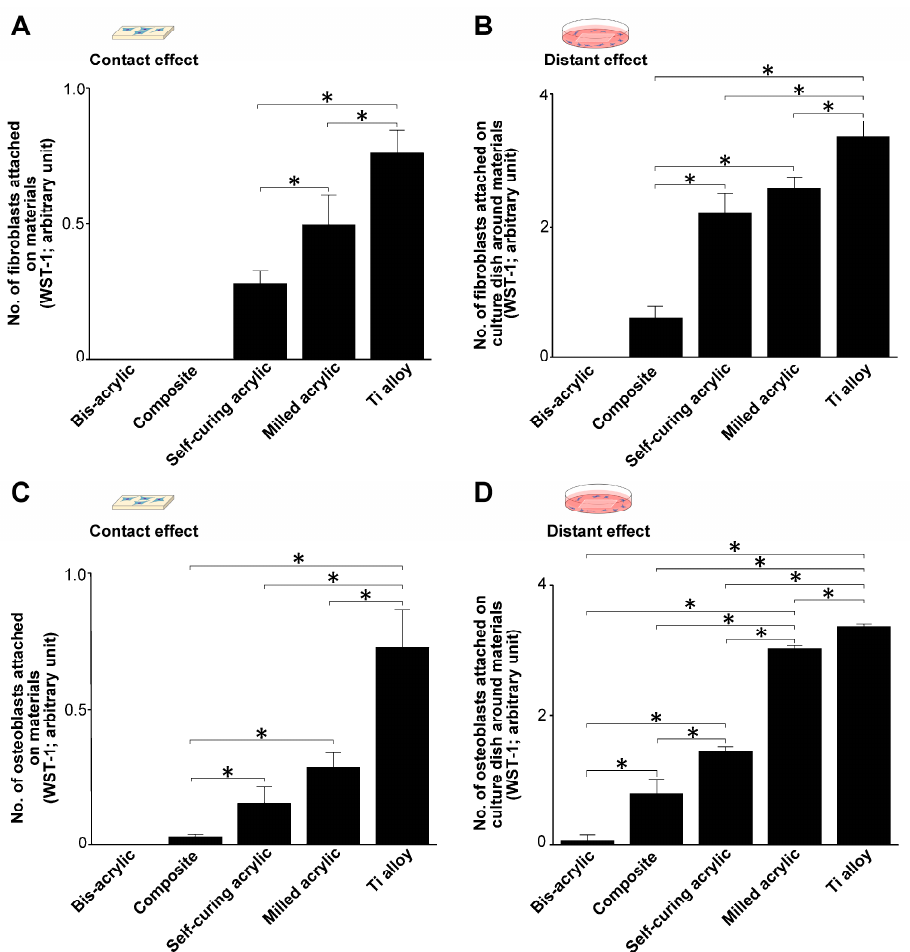
Figure 3. Successful attachment of fibroblasts and osteoblasts during initial culture (day 2). ( A ) The number of attached fibroblasts on test materials (contact effect). ( B ) The number of fibroblasts attached to the culture dish around the test materials (proximity effect). ( C ) The number of attached osteoblasts in contact experiments and ( D ) in proximity experiments. Data shown are mean ± SD. Significant differences are shown (one-way ANOVA with the Bonferroni post hoc test, * p < 0.05). Osteoblasts attached to milled acrylic, albeit ~50% less than to the Ti alloy. In contrast to fibroblasts, few osteoblasts attached to the composite (Figure 3C). In proximity experiments, osteoblasts attached around milled acrylic at ~90% of the level as around Ti alloy. A small number of osteoblasts also attached around bis-acrylic (Figure